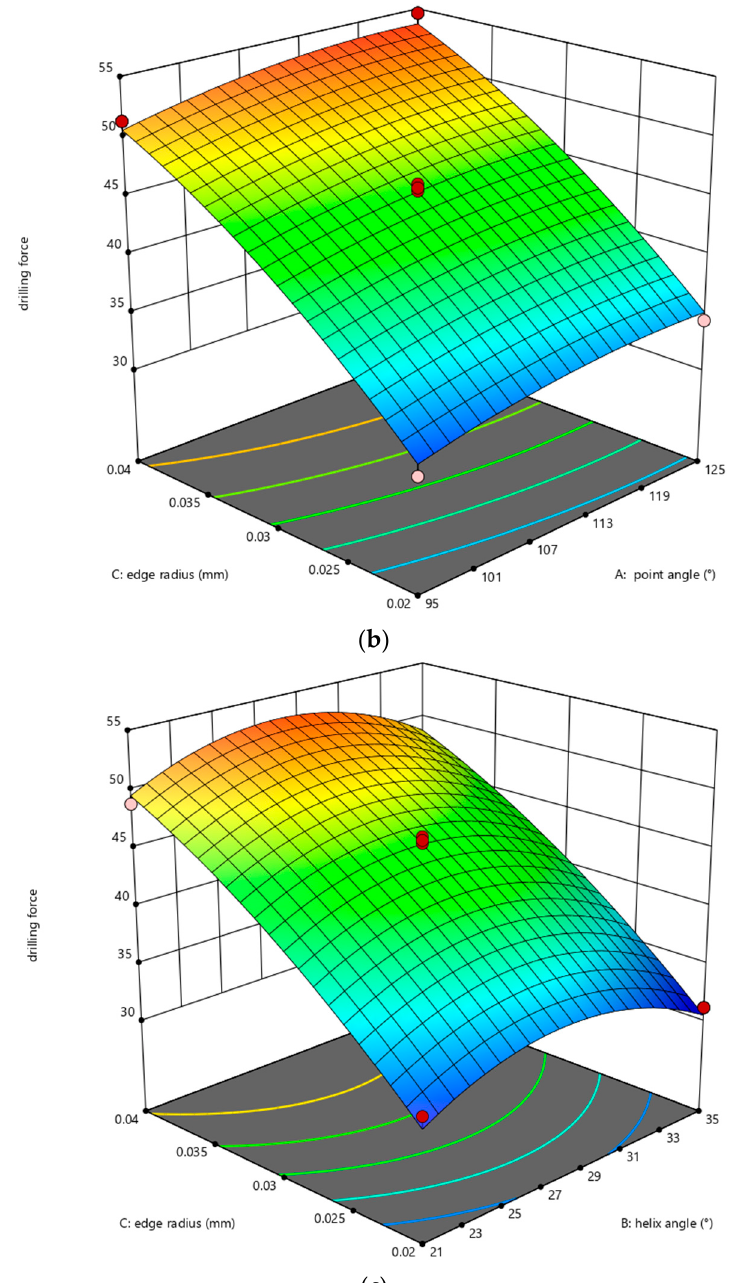
Figure 9. Influence of bit edge shape parameters on drilling force. ( a ) Influence of point angle and helix angle on drilling force; ( b ) Influence of point angle and edge radius on drilling force; ( c ) Influence of edge radius and helix angle on drilling force.